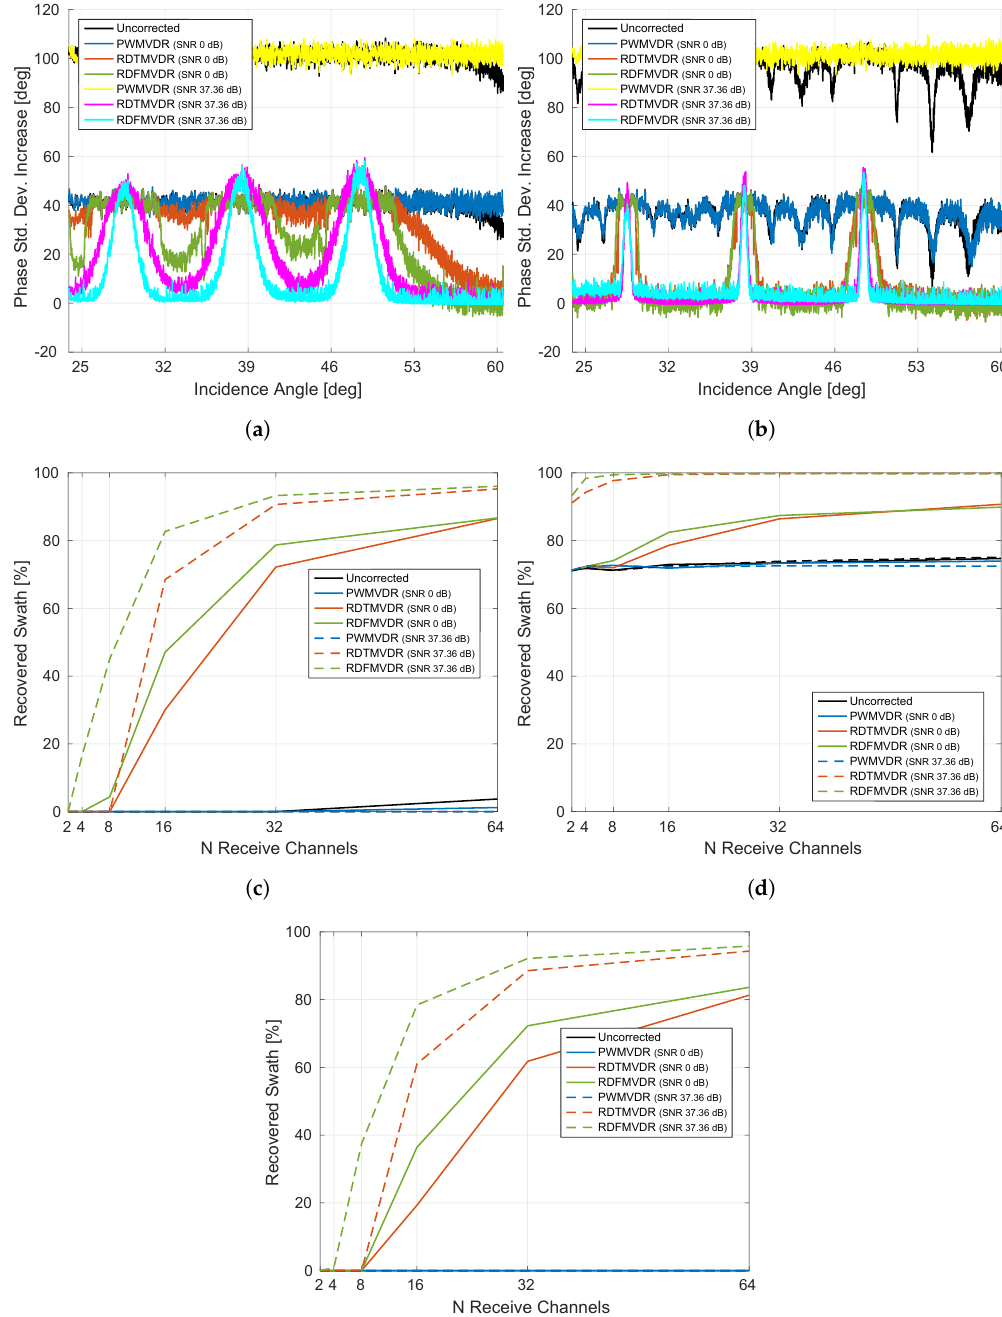
Figure 32. The phase standard deviation increase of the residual error image for scenario D at a RFI-Noise-Ratio of 40 dB. ( a ) Error plotted versus incidence angle for N = 16 and for SNR = 0 dB (pale lines) and SNR = 37.36 dB (saturated lines), ( b ) Error plotted versus incidence angle for N = 64 and for SNR = 0 dB (pale lines) and SNR = 37.36 dB (saturated lines), ( c ) The percentage of the recovered SAR swath that is within the phase std. dev. limits of 20°, ( d ) The percentage of the recovered SAR swath that is within the phase offset limits of 5°, ( e ) The percentage of the recovered SAR swath that is within the absolute gain limits of 0.5